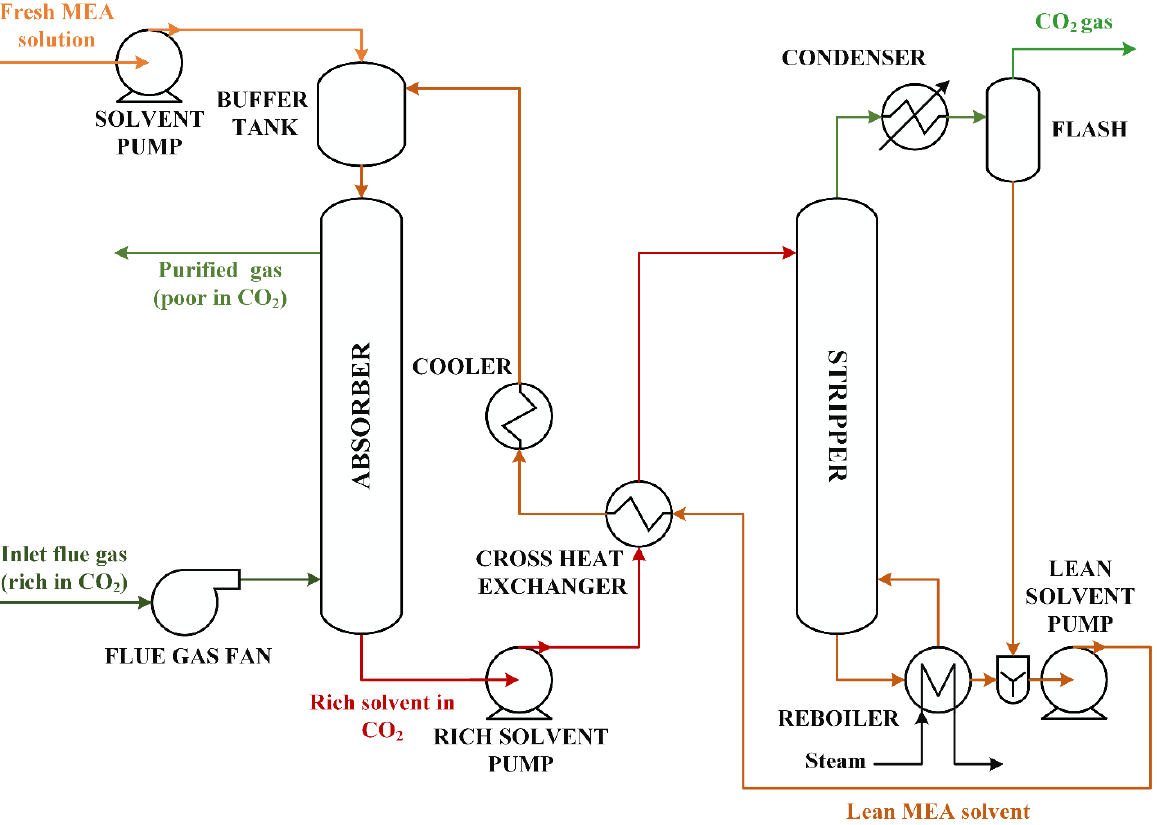
Figure 1. A schematic flowsheet configuration of CO 2 capture using aqueous MEA solution in an absorption – desorption gas – liquid process.